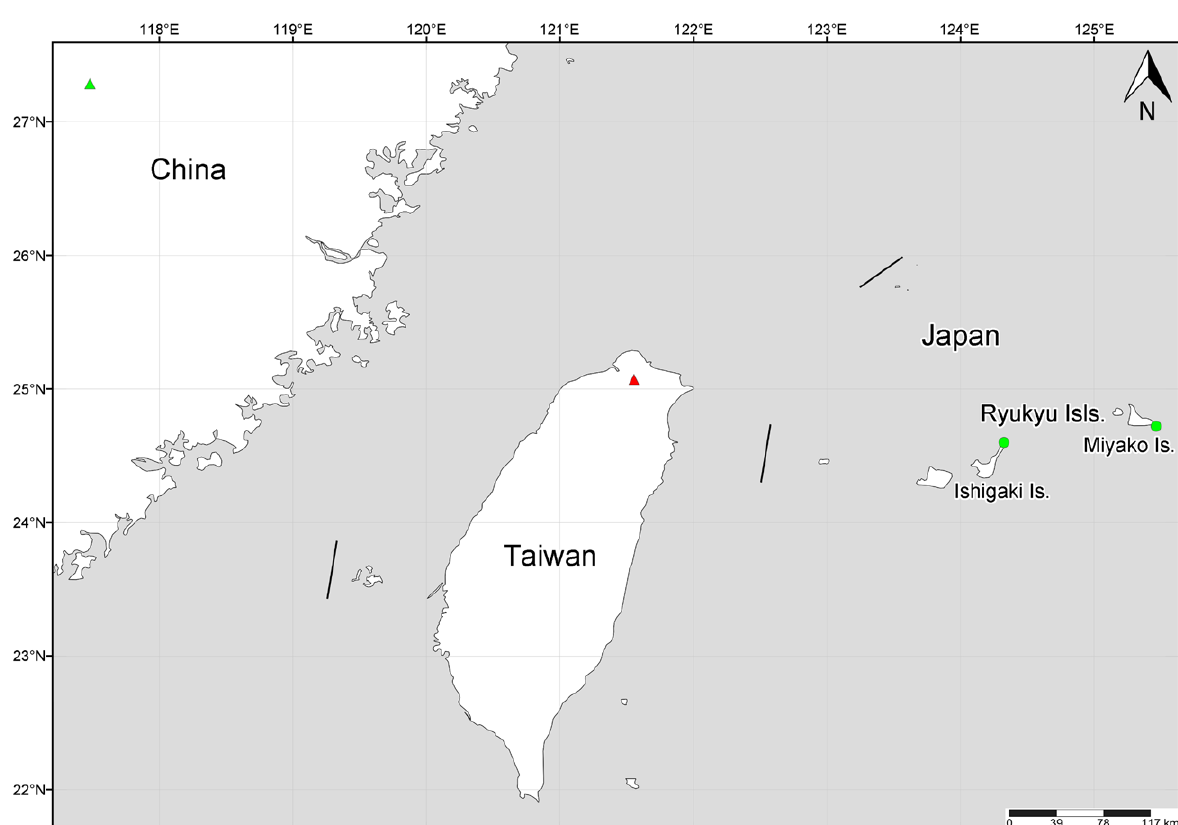
Figure 4. Collection sites of Lasiacantha altimitrata . Red icon = type locality; green icons = other localities. Circles = new records; triangles = known records.